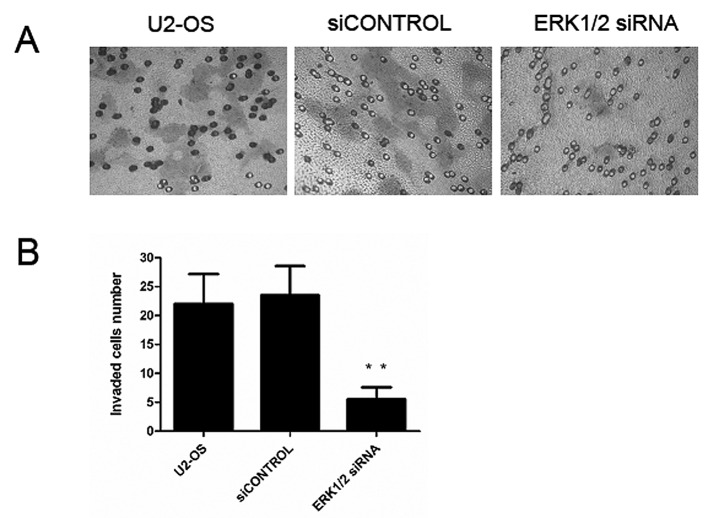
Downregulation of ERK1/2 suppresses osteosarcoma cell migration. (A) U2-OS, siCONTROL and ERK1/2 siRNA cells were induced to invade through Matrigel-coated transwell membranes. After 48 h, cells were fixed, stained and counted. (B) The cell numbers of ERK1/2 siRNA treated groups were significantly less than U2-OS and siCONTROL groups (P<0.01).